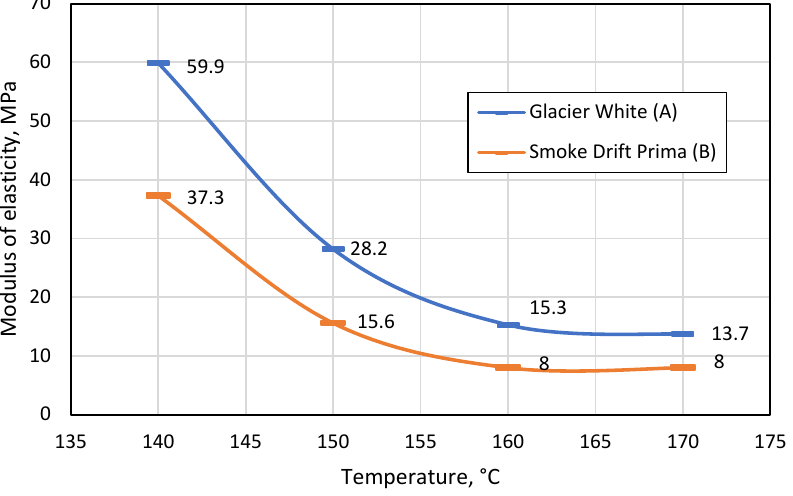
Figure 8. Change in the modulus of elasticity (MPa) of monochrome A and patterned B materials with increasing temperature when the distance between supports was 100 mm.